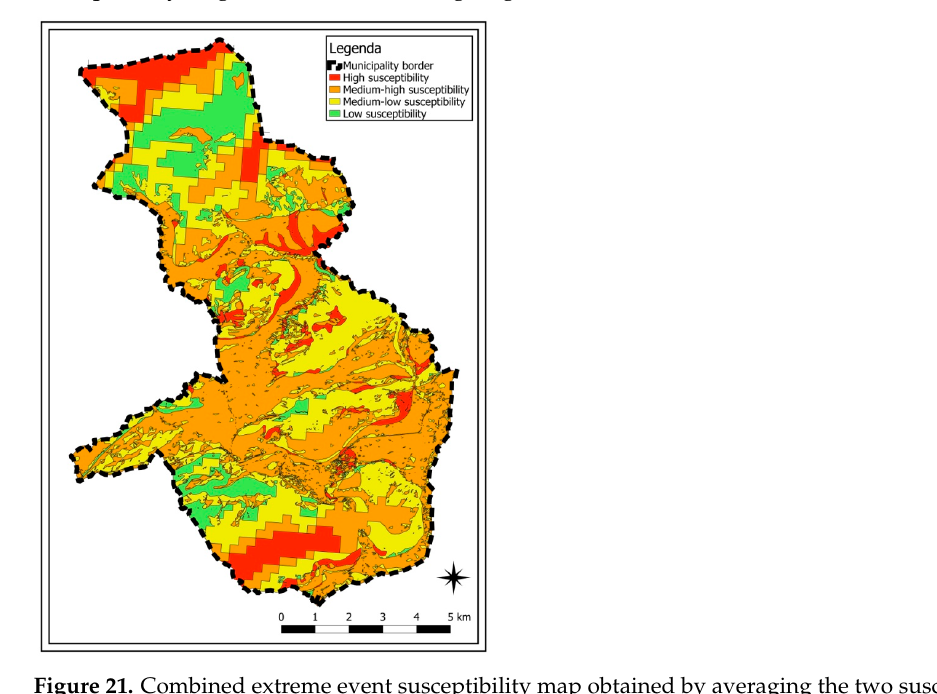
Figure 20. Susceptibility map with overlay of tree felling areas.